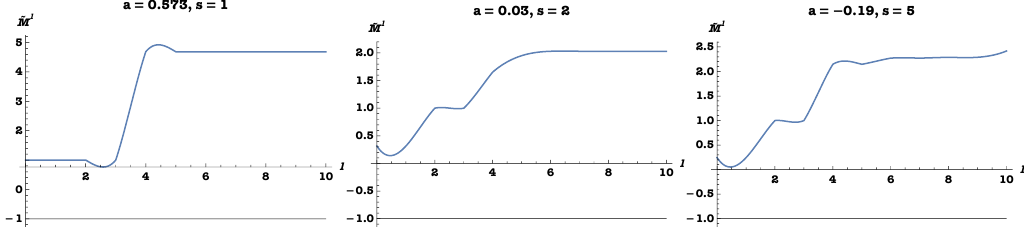
J ( s Figure 9: ˜ , a ) vs J for various values of a i M